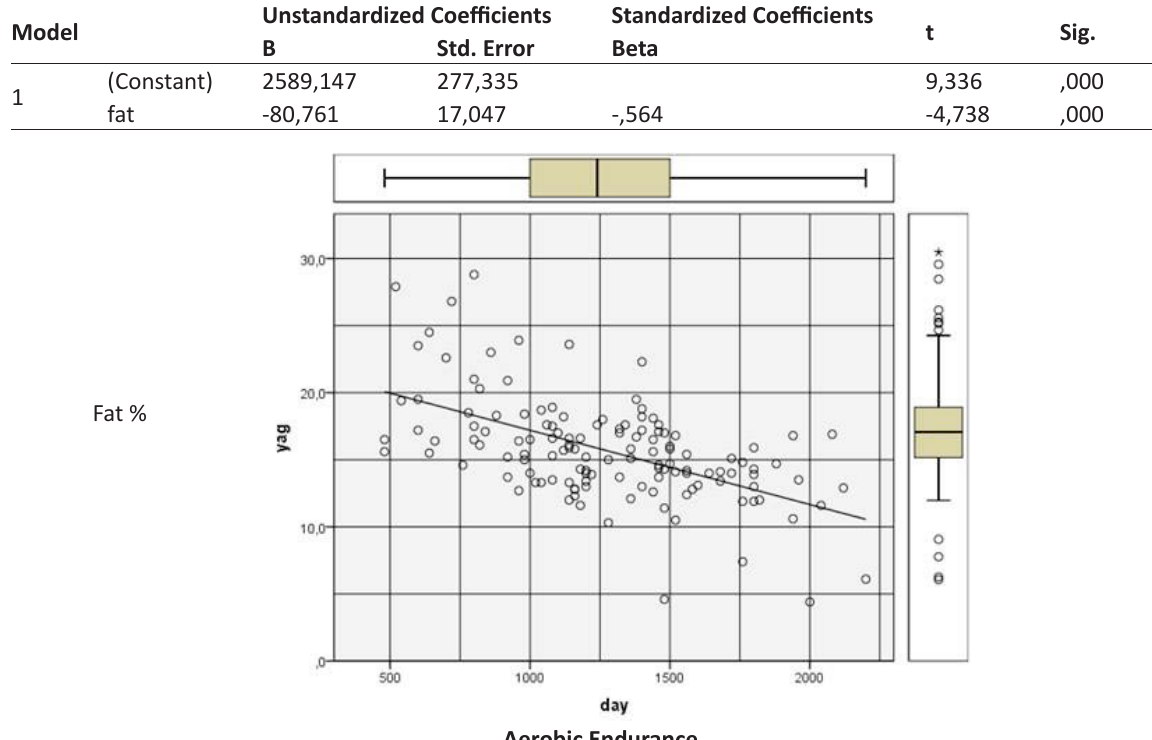
Table 6. The results of statistical analysis and corelation of measured variables Model